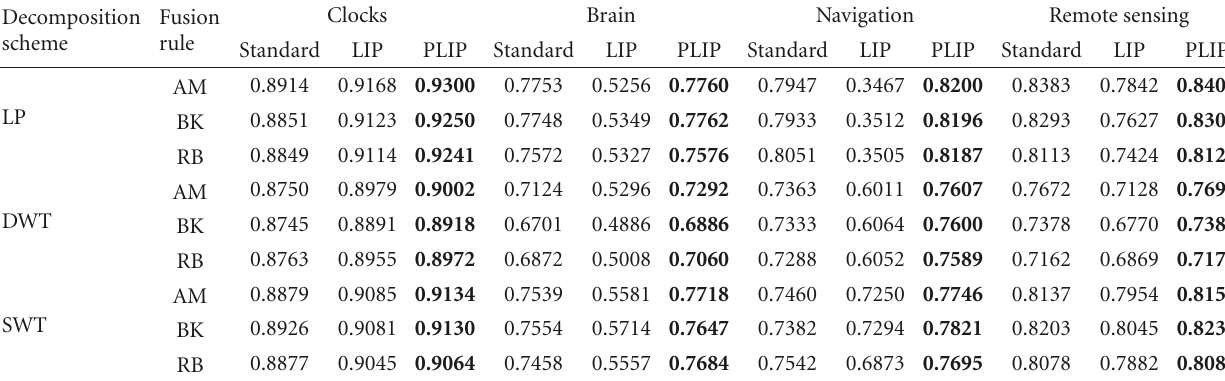
Table 2: Quantitative quality assessment of image fusion results using the Piella and Heijmans quality metric.